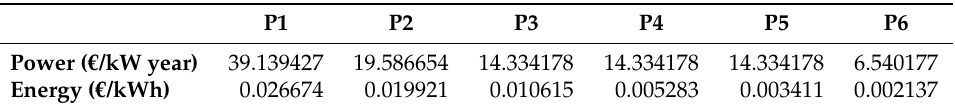
Table 1. Yearly prices of contracted electricity power and energy for tariff 6.1A (HV) in Spain. P1 is the most expensive period, while P6 is the cheapest one. P1 P2 P3 P4 P5